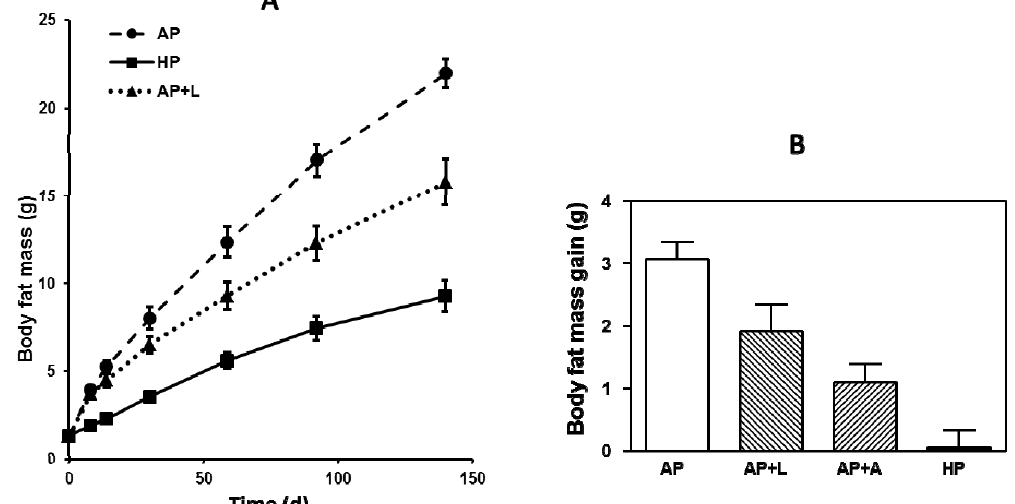
Figure 2. ( A ) Long term body fat accumulation. Ten weeks old male C57BL/6 mice were fed for 20 weeks ad libitum with experimental semisynthetic high-fat diets (20% w / w of fat) containing different protein and leucine concentrations. AP, adequate protein (10% w / w of whey protein); HP, high-protein (50% w / w of whey protein); AP + L, AP supplemented with L -leucine corresponding to HP (+6% L -leucine) [8]; ( B ) Short term body fat mass gain. Ten weeks old male C57BL/6 mice were fed for 7 days ad libitum with experimental semisynthetic high-fat diets (20% w / w of fat) containing different protein and leucine and alanine concentrations. AP, adequate protein (10% w / w of whey protein); HP, high-protein (50% w / w of whey protein); AP + L, AP supplemented with L -leucine corresponding to HP (+6% w / w L -leucine, 0.572 mole); AP + A, AP supplemented with equimolar L -alanine (+4.5% w / w L -alanine, 0.572 mole). Data are means ± SEM, n = 9–10